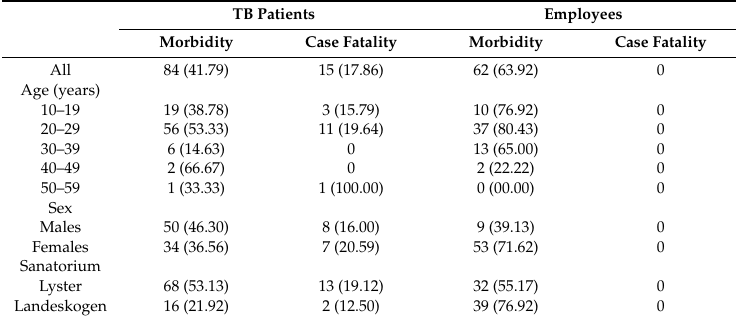
Table 2. Distribution of influenza-like illness (ILI) cases (% of pop) and ILI deaths (% of cases) by case-control